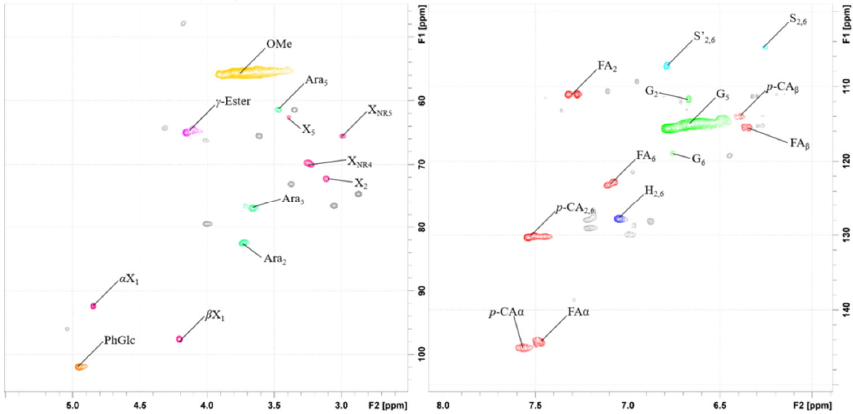
Figure 7. The 2D ‐ HSQC NMR spectra of membrane foulant. The cross ‐ signals assigned in the NMR Figure 7. The 2D-HSQC NMR spectra of membrane foulant. The cross-signals assigned in the NMR spectra are listed in Table S2 of the Supplementary Material. spectra are listed in Table S2 of the Supplementary Material. Table 6. Peak assignment of HSQC spectra of membrane